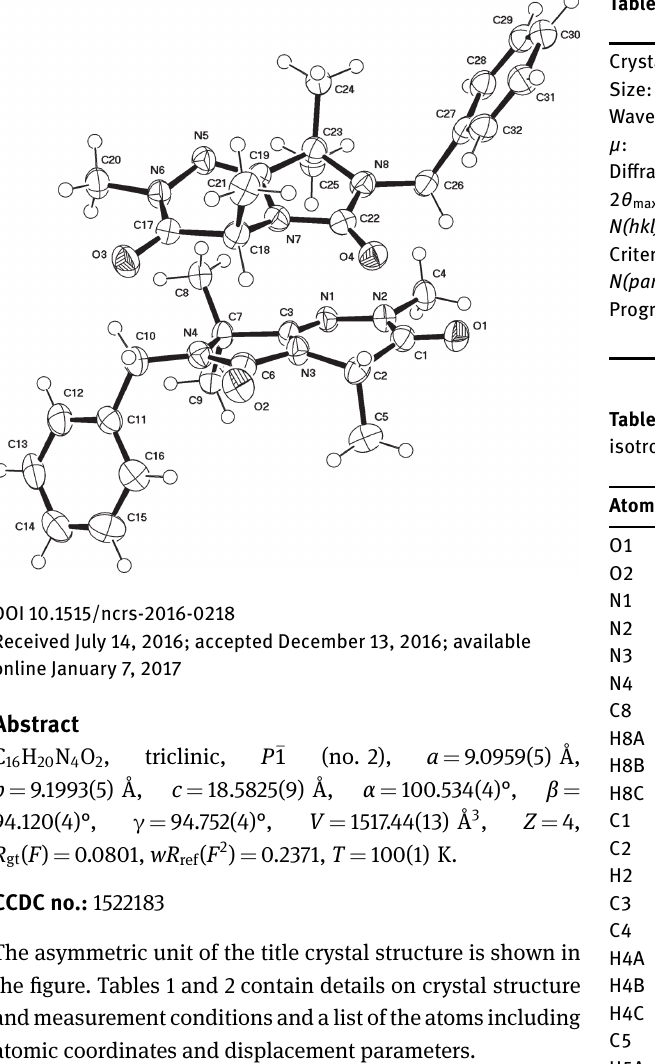
Table 1: Data collection and handling.